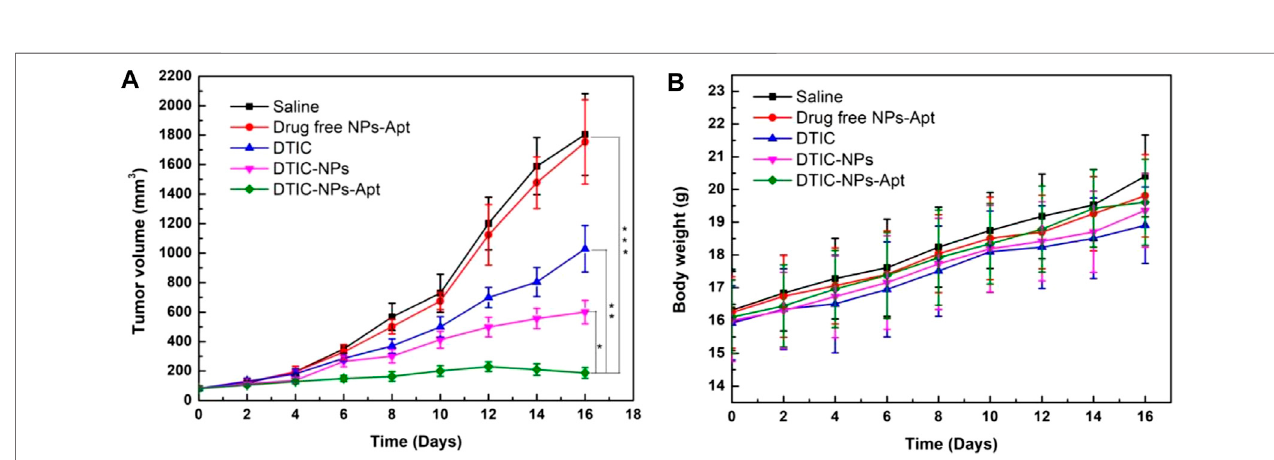
FIGURE7| Antitumoref fi cacyoftargetedDTIC-NPs-Aptincomparisonwithsaline,drugfreeNPs-Apt,freeDTIC,andDTIC-NPs( n =5). (A) Tumorgrowthcurveof theSCIDnudemicebearinghumanmelanomaA875cellsxenograft. (B) Animalbodyweightofthenudemiceindifferentgroupsaftertreatmentatdifferenttimeintervals. p p < 0.05; pp p < 0.01. ppp p < 0.001 indicate signi fi cant difference compared with